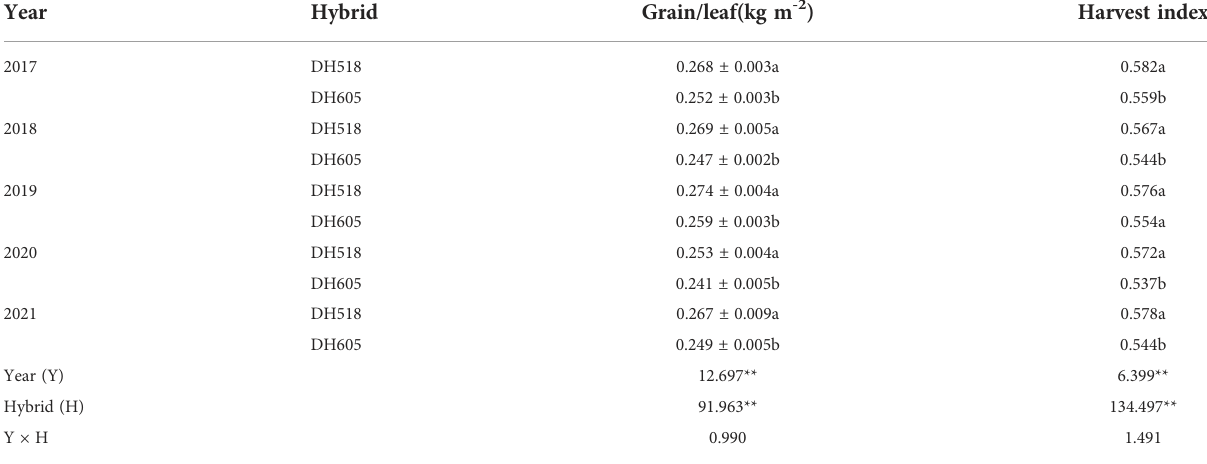
TABLE 8 Grain/leaf and harvest index of summer maize hybrids with different growth duration from 2017 to 2021.